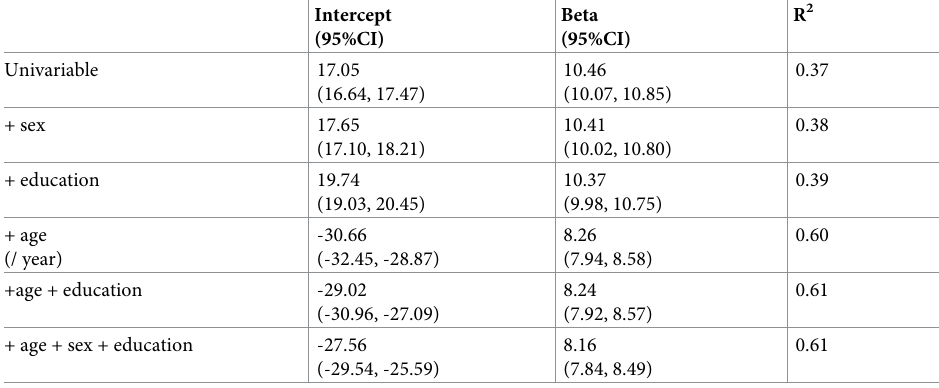
Table 2. Results from the linear regression analysis for the question: ‘Do you have any difficulty with your hear- ing?’. First, univariable analysis was done. Then each of the independent covariates were added, initially separately and later together. Beta’s reflect the number of decibel change in the PTA 0.5–4 with each step up in degree of subjective hearing loss (never, sometimes, regularly, or often). R 2 is given as a measure of the goodness of fit of the